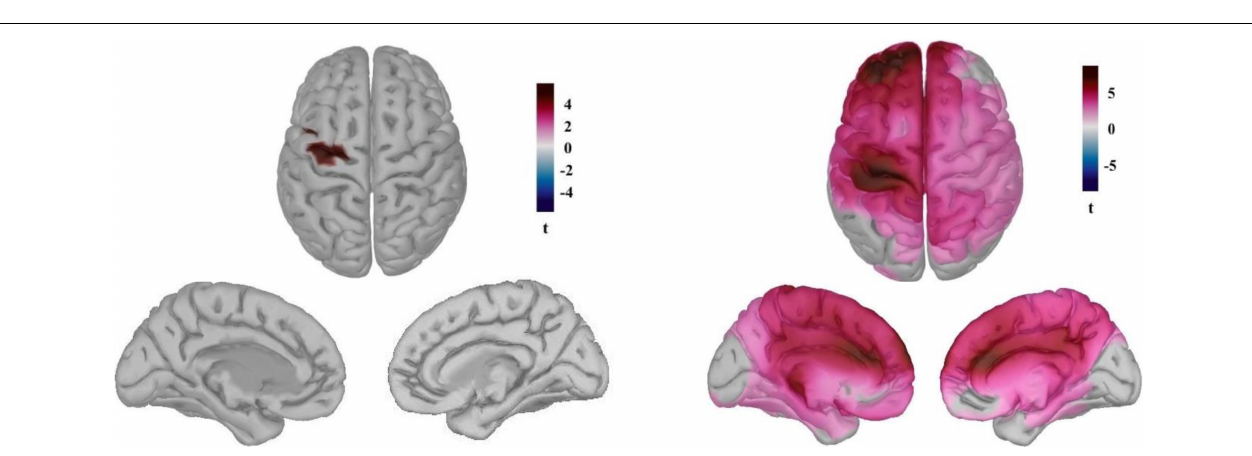
FIGURE 4 | Neural sources of the differential HEP observed for the pre-game and the game conditions for the gamers (left) and the non-games (right) . (t pertains to permutation test results considering α < 0.05 with the FDR